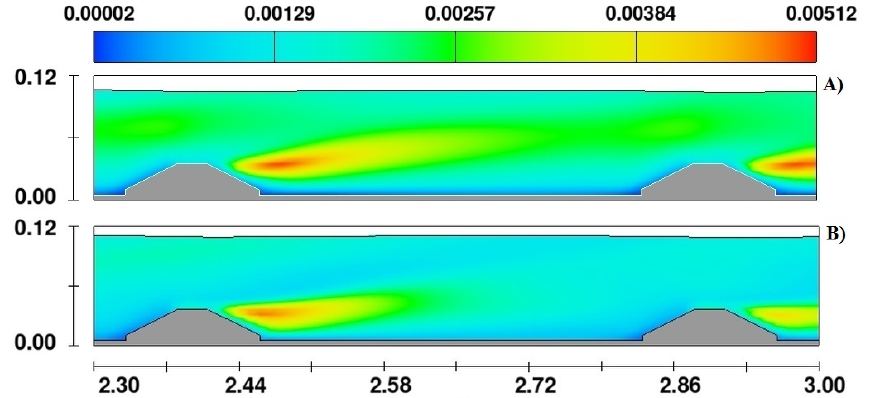
Figure 10. TKE (m 2 s − 2 ) in the XZ plane of the EZ (dim in meters) for ( A ) RNG Model and ( B ) k-epsilon model.